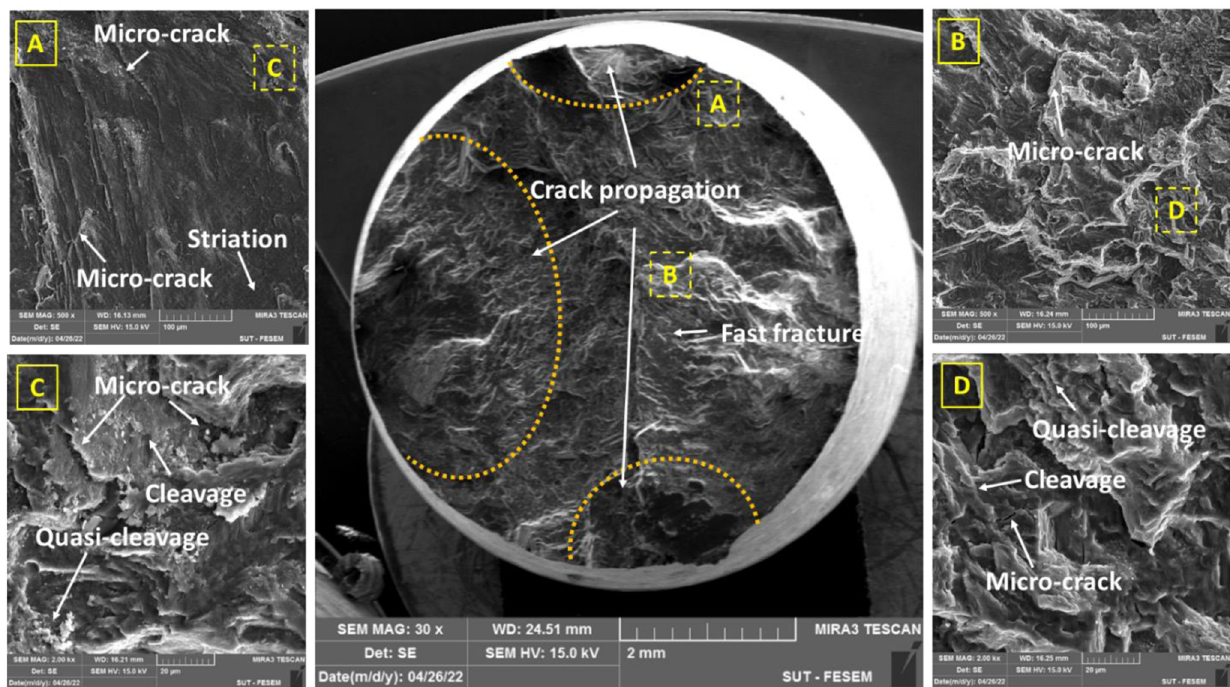
Fig 7. The fracture surface under pure fatigue conditions (the stress level: 80 MPa).